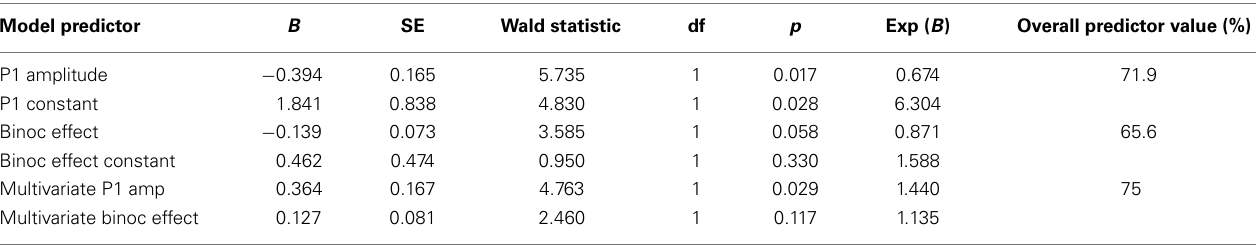
Table 2 | Coefficients of univariate logistic regression models that were evaluated: univariate models for two features, then a multivariate model incorporating both features .